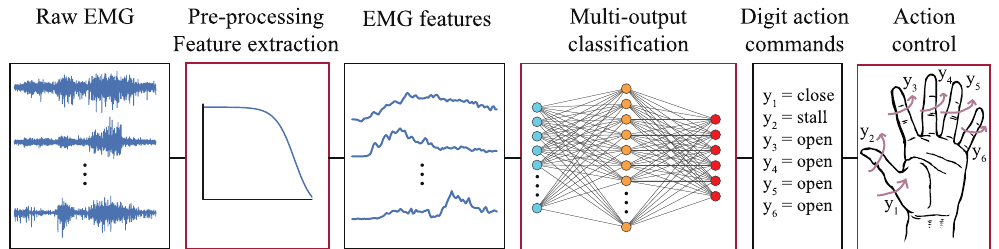
Figure 1. Action decoding paradigm. Multi-channel raw EMG measurements are pre-processed and fed as inputs into a multi-output classifier. The classifier has six outputs corresponding to the following DOFs: thumb rotation and flexion/extension of the thumb, index, middle, ring, and little digits. For each DOF, the algorithm classifies movement intent into one of three actions: open, close, or stall (i.e., no movement). Predictions can then be used to control the digits of a prosthesis using discrete actions. Any type of multi-output, multi-class classifier can be used as the